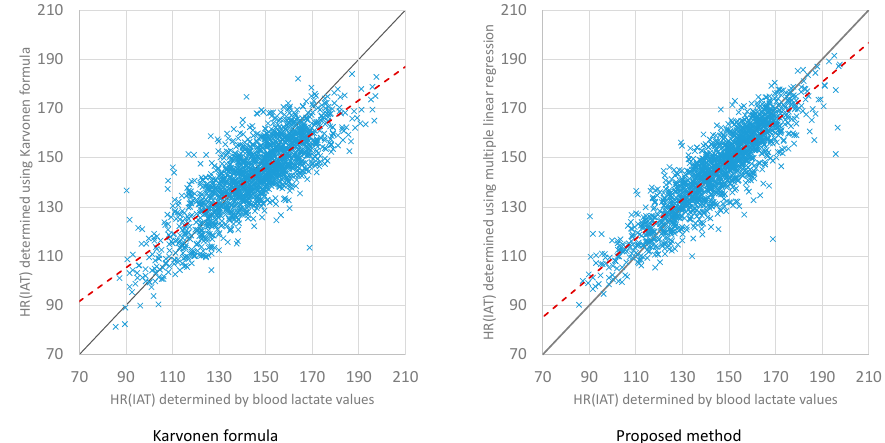
Figure 2. Comparison between regression model and Karvonen formula. The essential parameter W/kg(IAT), which is especially important for determining changes in performance, was also examined. As explained above, the respective input pa- rameters were iteratively removed unless they met a level of significance p < 0.001. This includes the removal of the heart rate recovery (HRR = HRmax-HR after 5 min of recov- ery) parameter, as its significance level was p = 0.057. As a result, only the following four parameters were included for multiple linear regression analysis to determine W/kg(IAT): gender; body weight (kg); mean power (P mean ); maximum power (P max ); maximum HR (HR max ). Using these parameters in multiple linear regression (Figure 3), the determination of W/kg(IAT) is possible with a root mean square error, RMSE = 0.241 W/kg. The adjusted R-squared was 0.897. Figure 3 shows the comparison between W/kg(IAT) values on the horizontal axis determined by means of blood lactate values and the W/kg(IAT) values on the vertical axis determined by means of multiple linear regression. Figure 3. Impact of the individual input parameters on the W/kg (IAT). To better understand the impact of individual input parameters on the W/kg (IAT), we have visualized the regression parameters using an effect plot in Figure 4. For this, we multiplied the weights of the formula in Figure 3 with the actual values in our database. The latter are normalized by subtracting their respective mean values, as this offset is al- ready modeled in linear regressions, in our case 2.2306 W/kg. Figure 4. Effect plot for individual input parameters on W/kg (IAT) with parameter values normal- ized to a mean of zero for better comparison. 4. Discussion This retrospective analysis of this dataset was examined to predict heart rate at IAT as well as training load (W/kg) at IAT without measuring blood lactate values for cycle ergometry. Both heart rate and the number of watts at the individual anaerobic threshold are essential parameters for training control. These parameters are currently best deter- mined via blood lactate diagnostics during ergometry performance testing. A total of 1234 performance protocols with blood lactate in cycle ergometry were analyzed. Multiple lin- ear regression analyses were performed to predict the essential parameters heart rate at individual anaerobic threshold (HR(IAT)) and workload at individual anaerobic thresh- old (W/kg(IAT)) by using routine parameters for ergometry without blood lactate. HR(IAT) can be predicted with a root mean square error, RMSE of 8.77 bpm ( p < 0.001). The intention of this regression model is the acceleration of preventive medicine by using